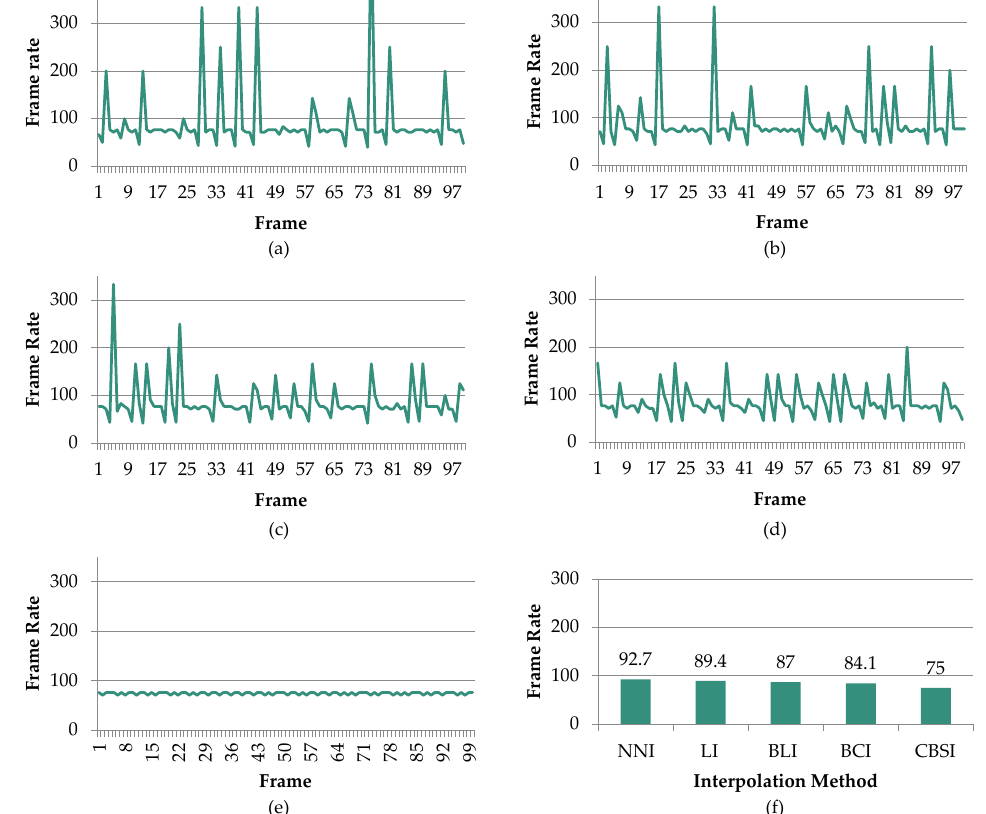
Figure 8. The time performance of rendering the cube surface light field using different interpolations. ( a ) NNI, ( b ) LI, ( c ) BLI, ( d ) BCI, ( e ) CBSI, ( f ) the average frame rate of each interpolation method.